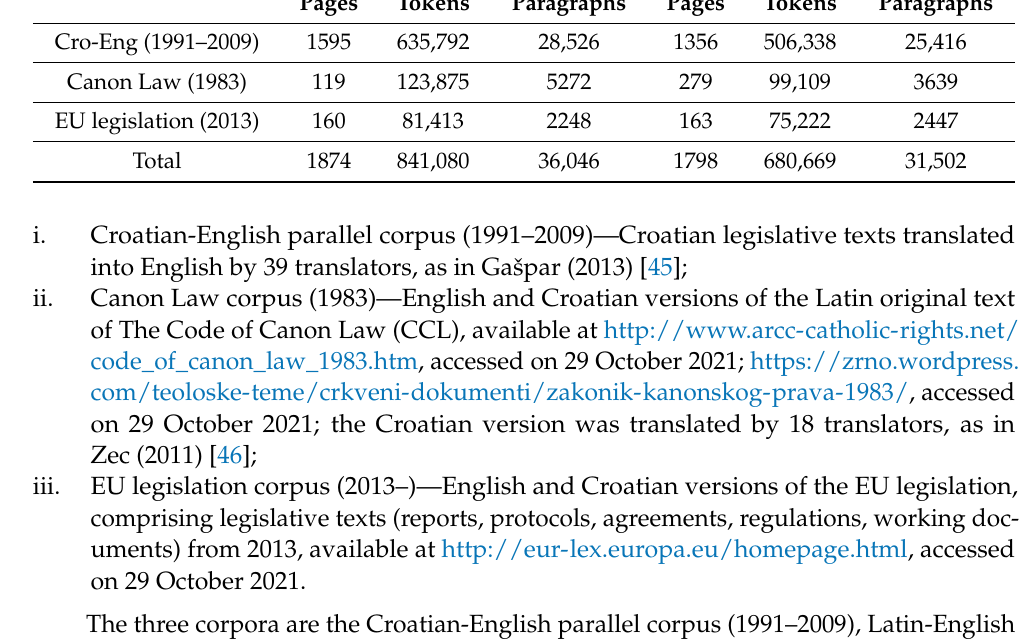
Table 1. Corpora statistics. Parallel